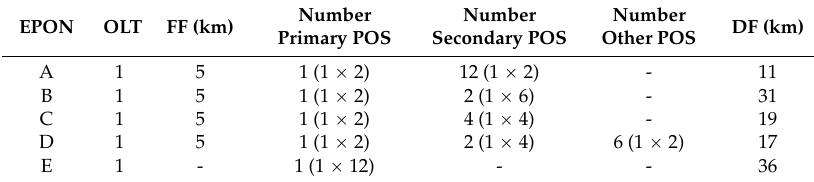
Table 1. Network elements of small wind power farms (WPF) (unprotected).